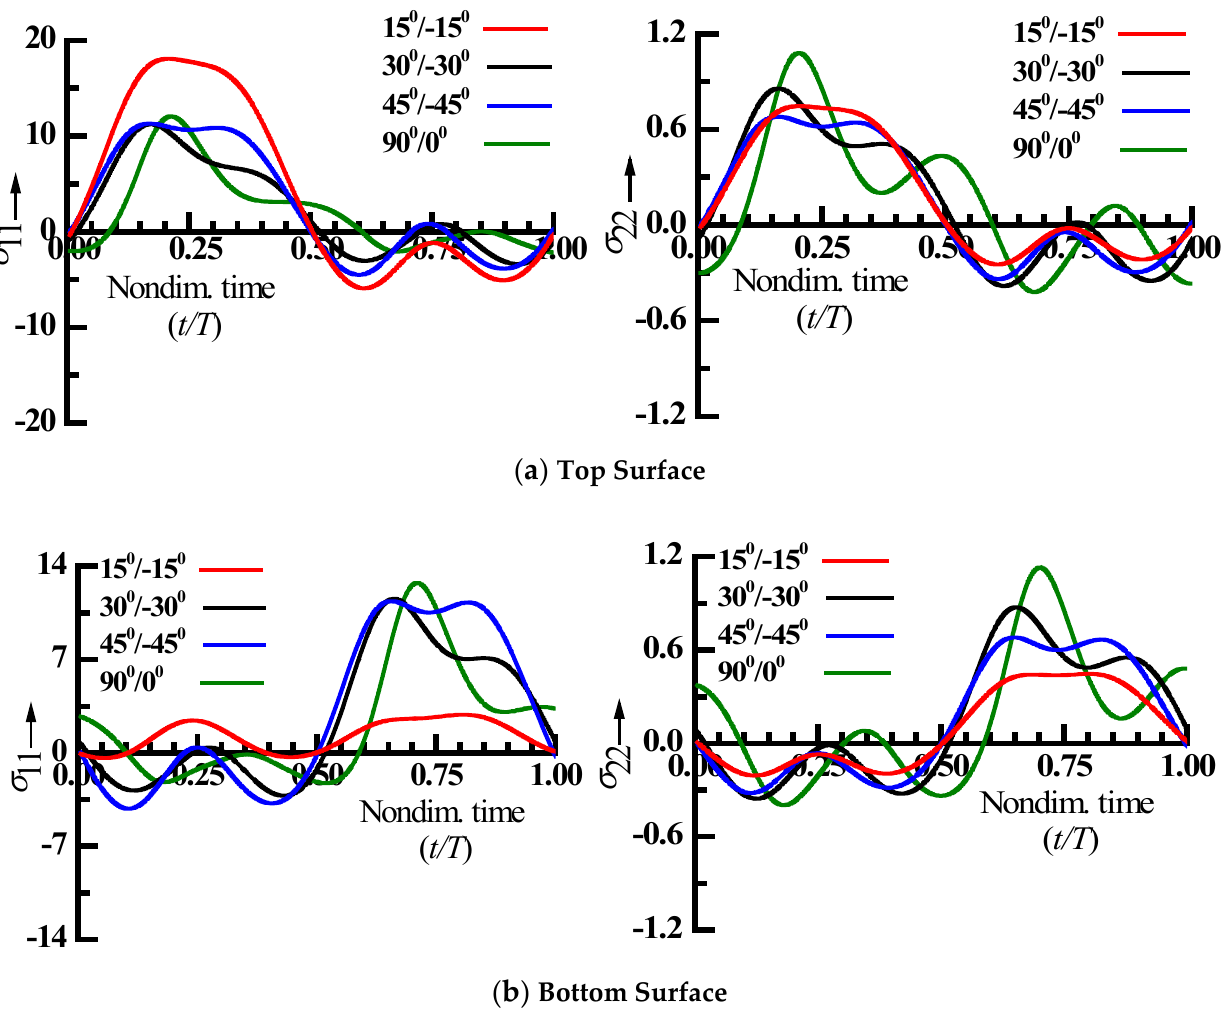
Figure 5. Nonlinear periodic stress (σ 11 and σ 22 ) distributions for top ( a ) and bottom surface ( b ), respectively. The contributions from the higher harmonics as revealed from the cyclic variations of the nonlinear stress were quantified by obtaining the frequency spectrum of nonlinear steady-state stresses ( σ 11 and σ 22 ) employing the fast Fourier transform (FFT), and the findings are shown in the Figure 6. FFT shows a significantly greater higher harmonics participation together with the fundamental harmonic for all fiber orientations. The second harmonic contributions for two-layered angle ply plate with 15 ◦ / − 15 ◦ lamination scheme at the centre of the bottom surface is greater than the fundamental harmonic. This is